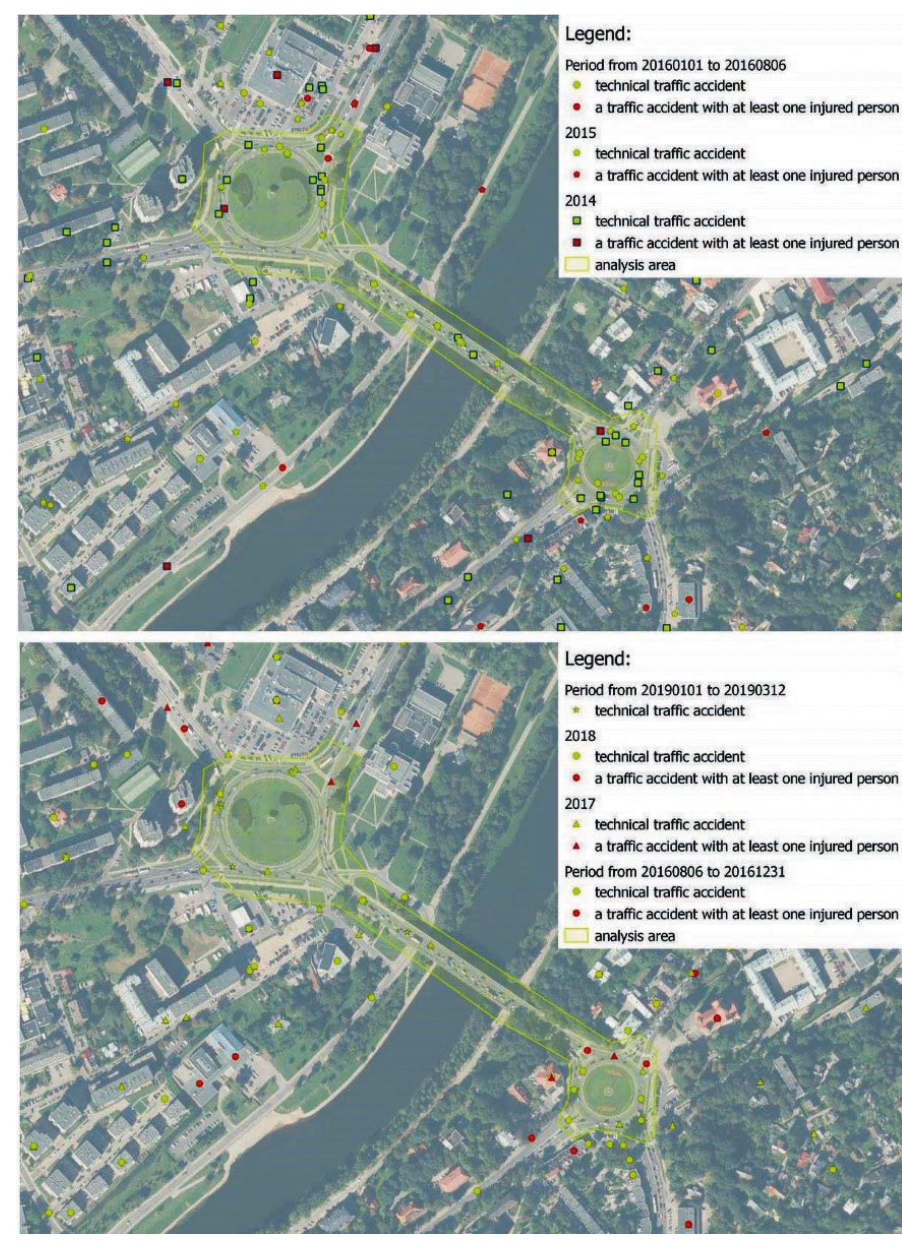
Figure 8. Location and type of traffic accidents before (top) and after (bottom) traffic reorganisation on 6 August